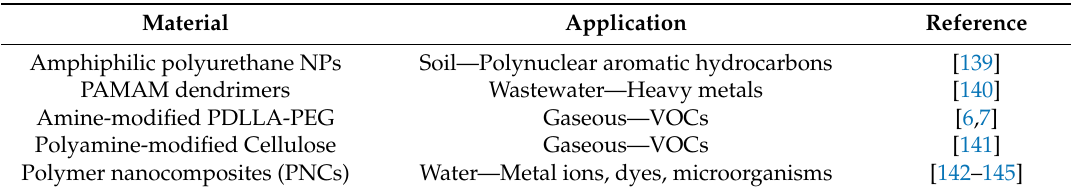
Table 4. Polymer-based materials for environmental remediation of